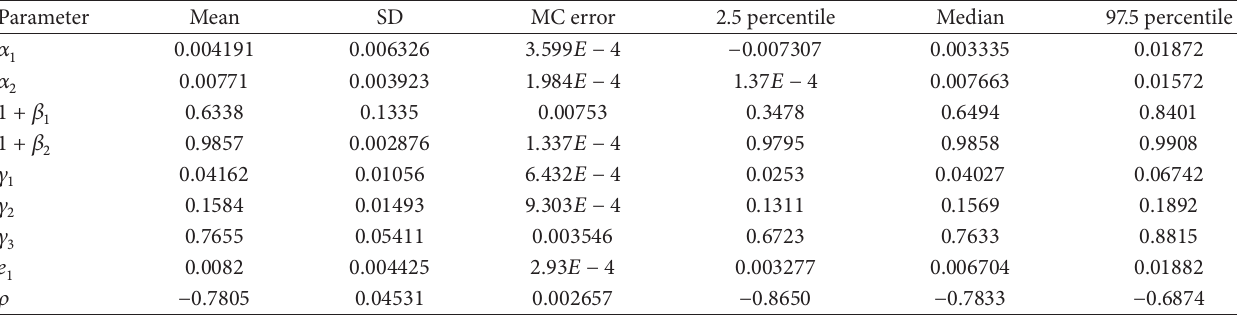
Table 5: Estimation results for S&P500.